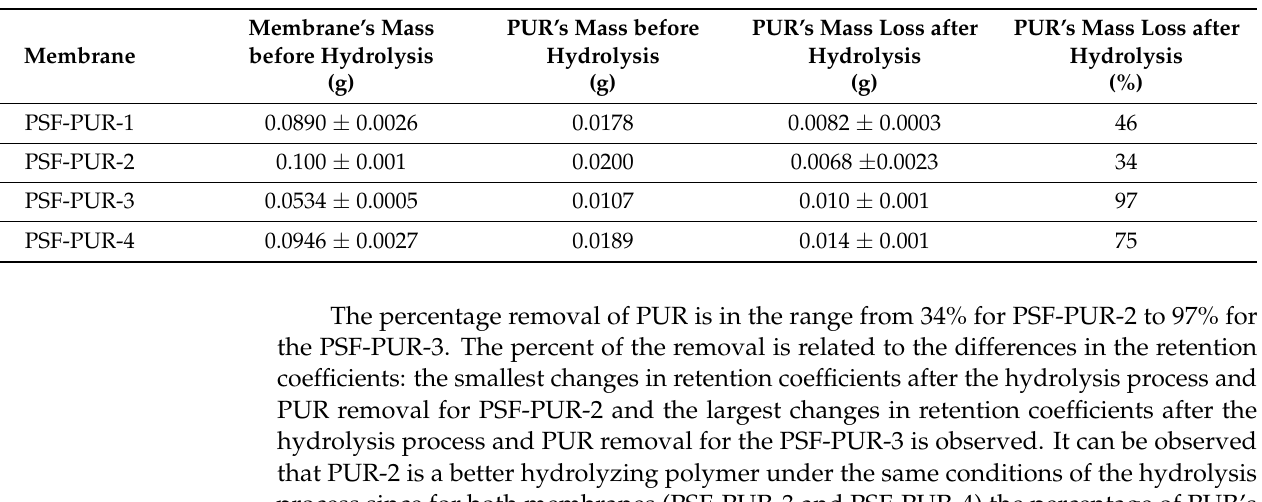
Table 4. The results of PUR’s mass